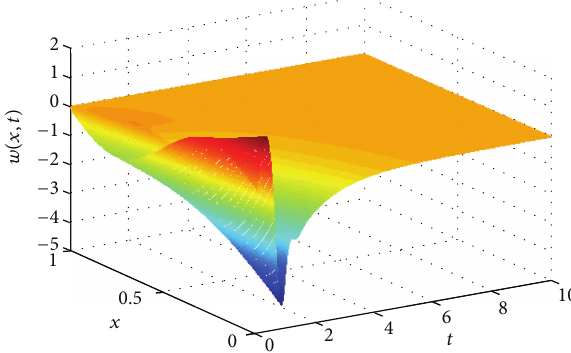
Figure 11: The response of the closed-loop system with control acting on [0.8,1] ( 𝛾 = 4.5 ).